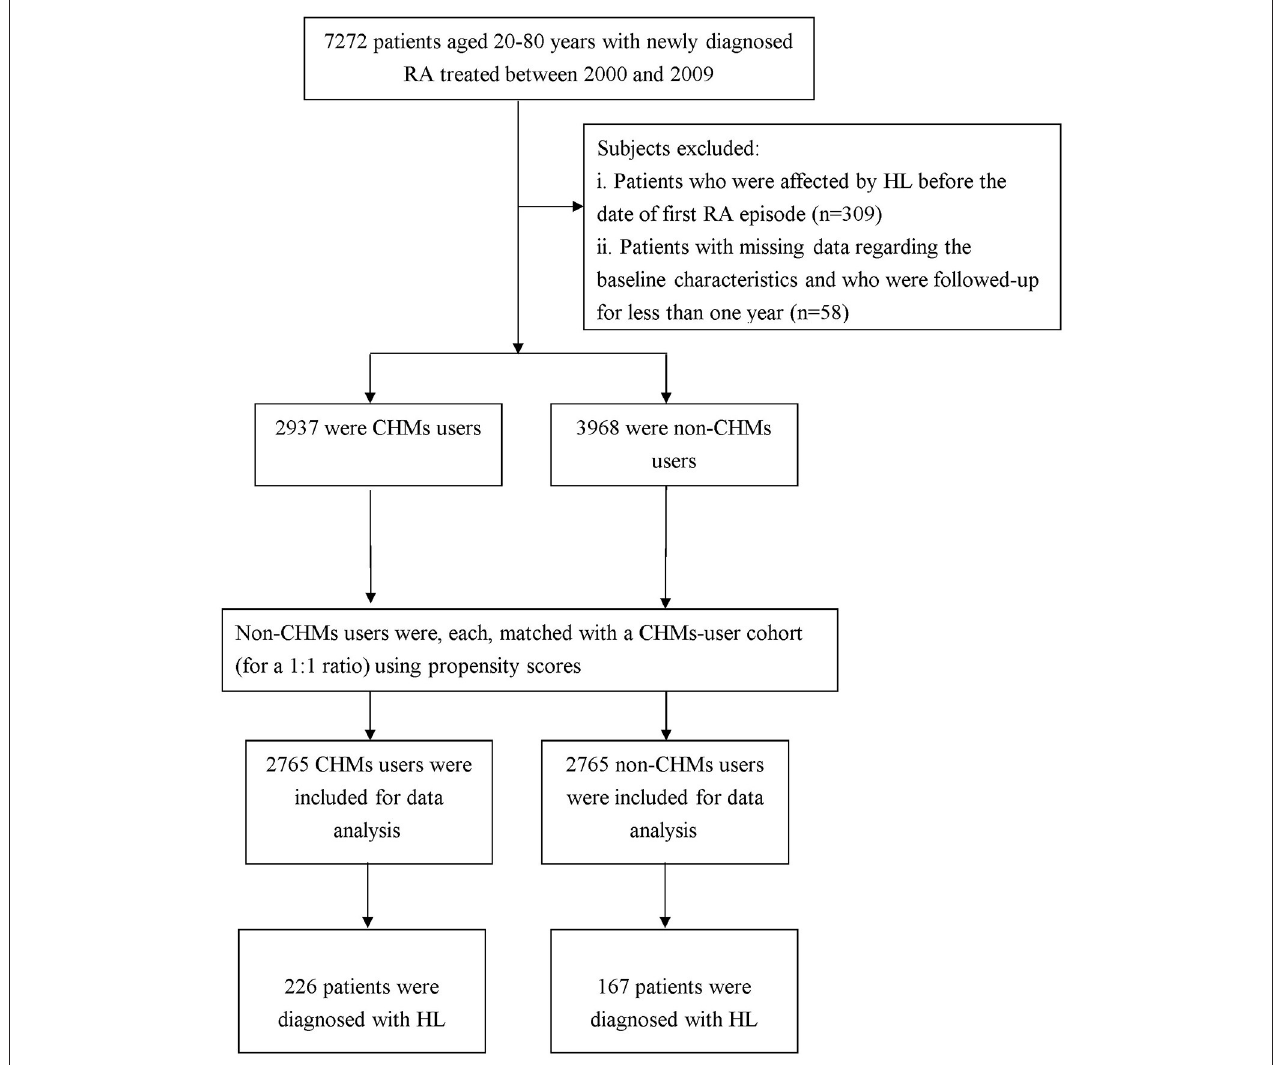
FIGURE 1 | Flowchart showing the method of selecting and following study